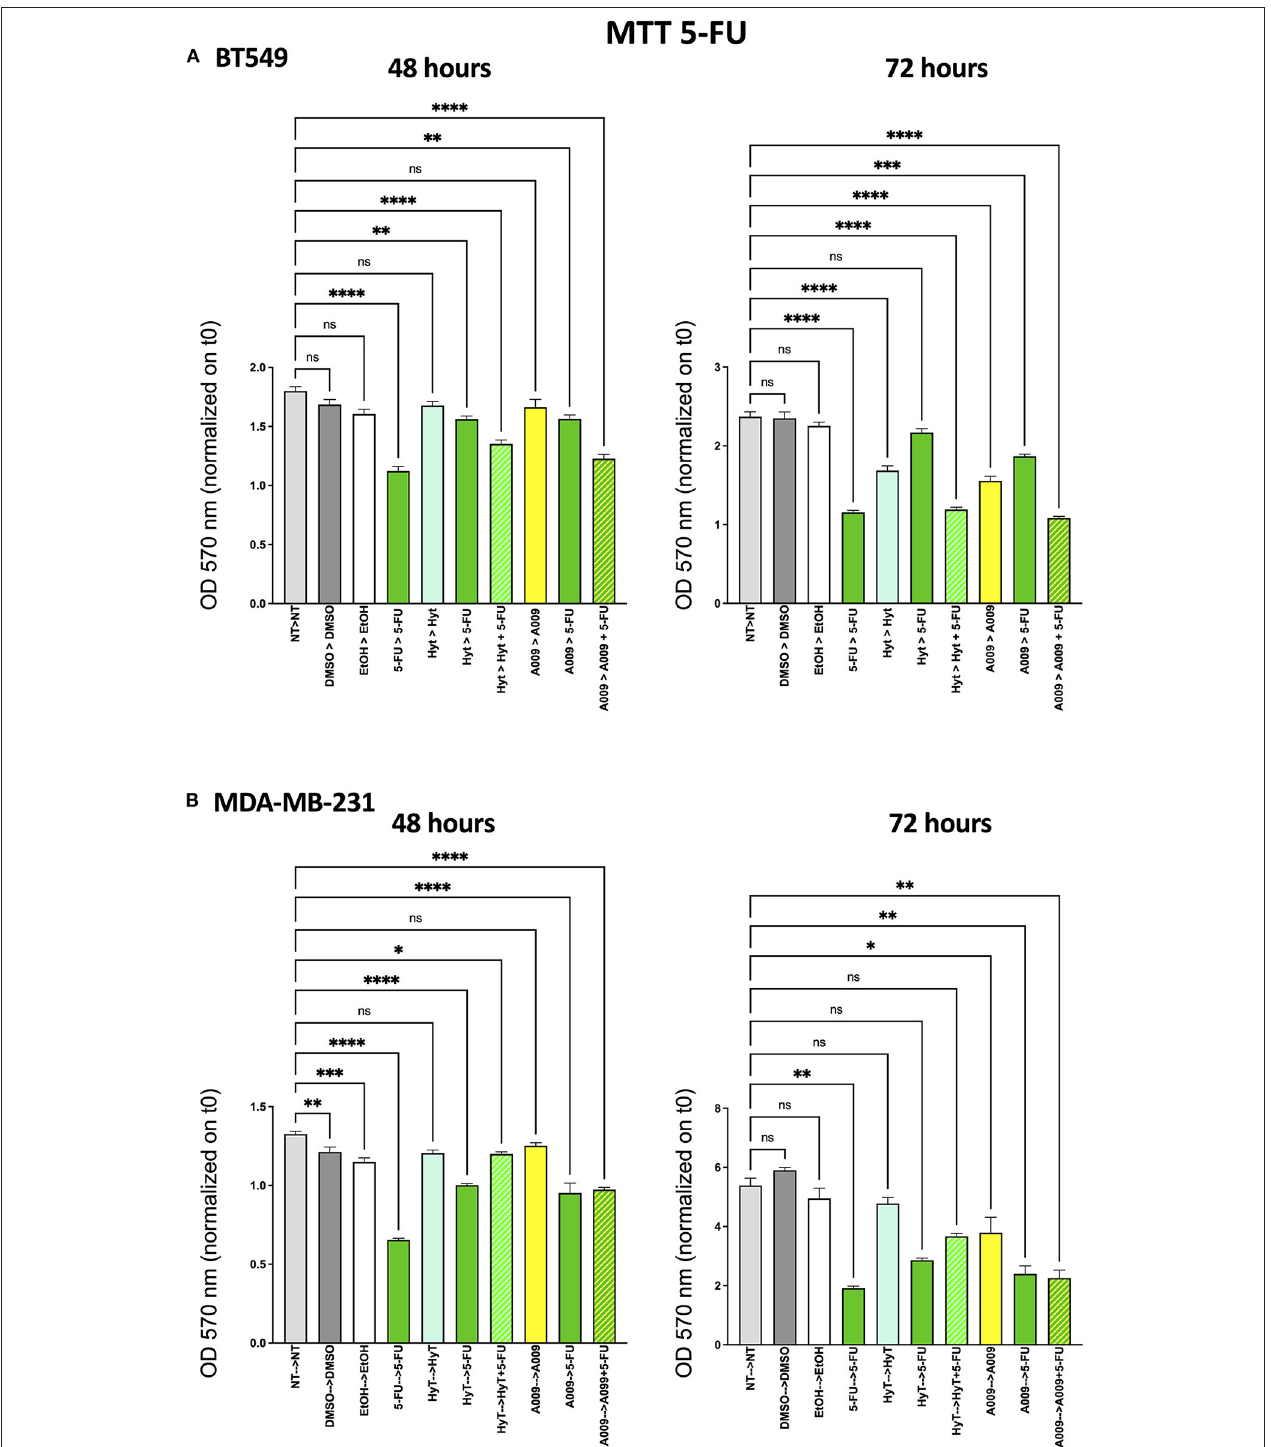
FIGURE 2 | Effects of the A009 extract in combination with 5-fluorouracil (5-FU) on breast cancer cell lines. BT549 (A) and MDA-MB-231 (B) cells were pretreated with extract A009 (dilution 1:800) or hydroxytyrosol (Hyt) (same concentration as that present in the 1:800 diluted A009 extract), for 24h. Later, the medium was replaced with 5-FU 100 µ M alone or in combination with A009 or Hyt for 48 and 72h. Proliferation was detected by the MMT assay at the indicated time points. The experiments were performed in quadruplicate and repeated two times. Results are expressed as the mean of the absorbance normalized on the T0 ANOVA, * p < 0.05, ** p < 0.01, *** p < 0.001, and **** p < 0.0001. A009 activity was enhanced by addition of chemotherapy towards breast cancer cells.